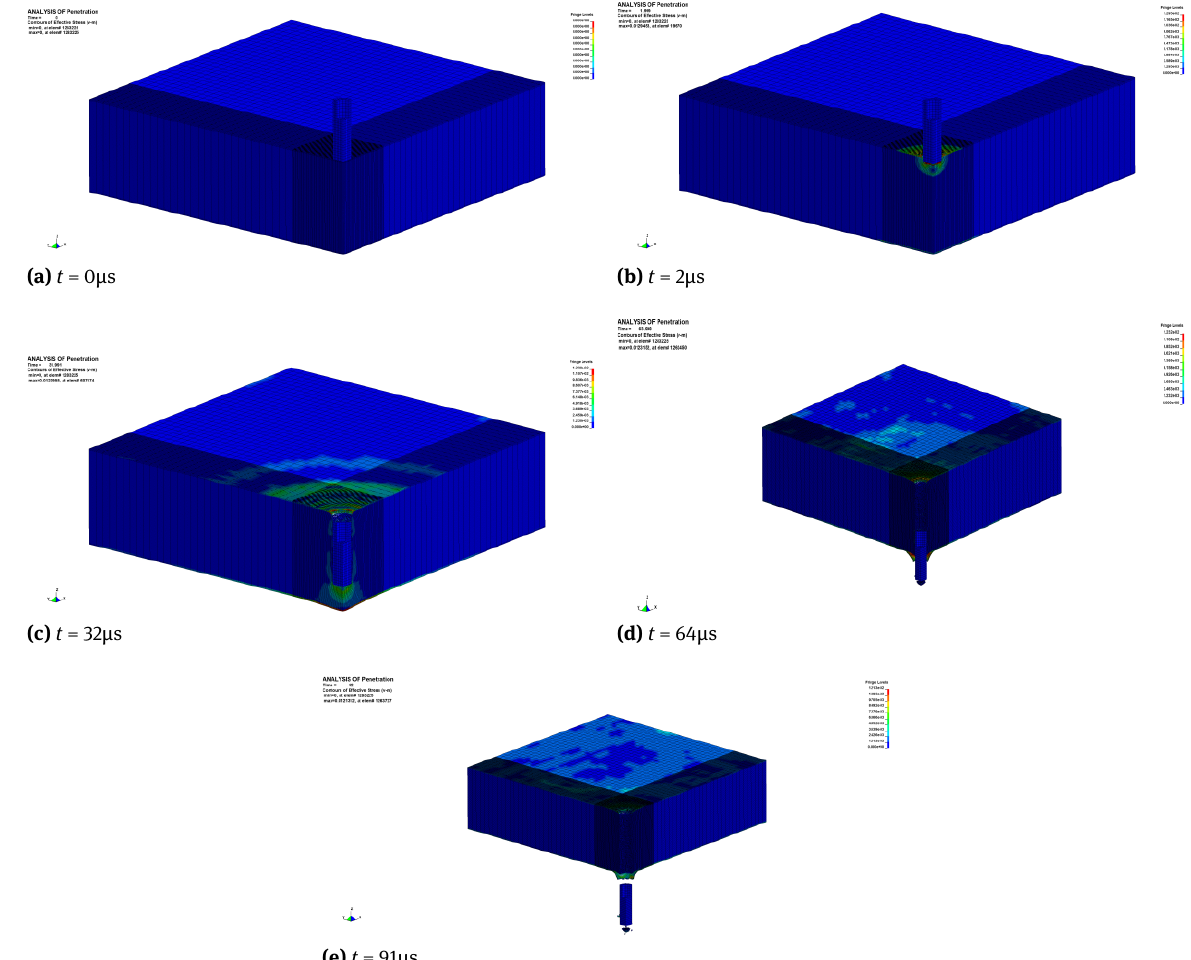
Figure 10: Deformation of steel-nylon sandwich plates impacted by blunt-nosed